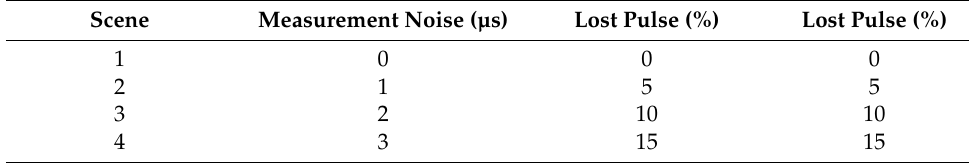
Table 2. Parameter setup of hybrid